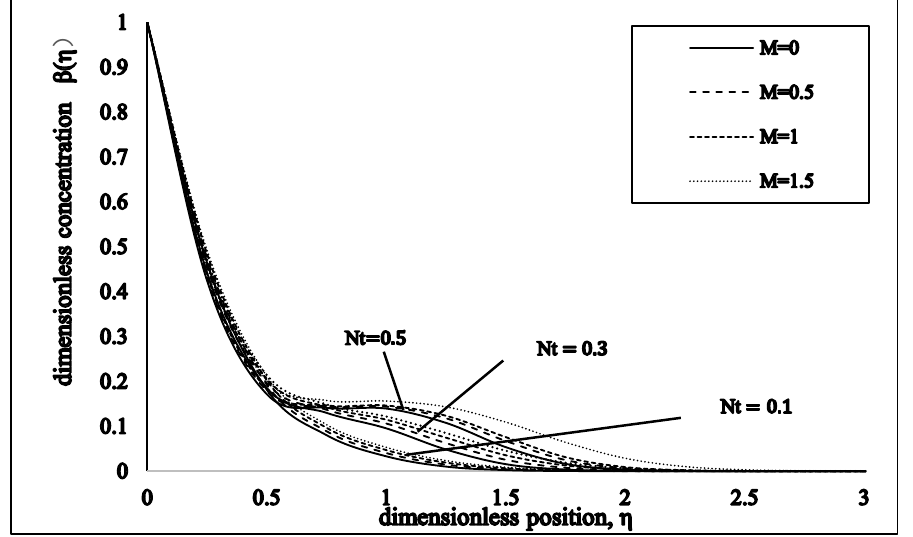
Figure 3. Impact of 𝑀, and 𝑁𝑡, when 𝑃𝑟 = 𝐿𝑒 = 10, 𝑁𝑏 = 0.5 and 𝐸𝑐 = 0.1 on concentration profile.